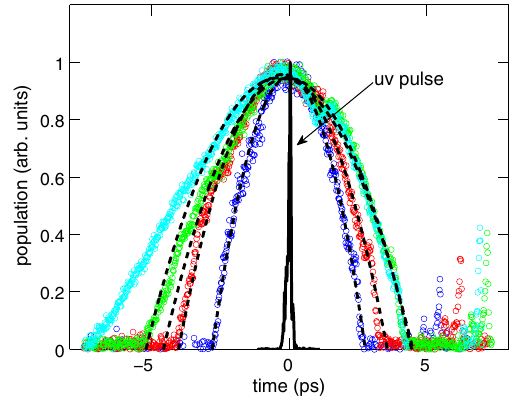
FIG. 12. Measured peak-normalized temporal profiles for Q ’ 130 , 280, 460, and 700 pC (respectively shown as blue, red, green, and cyan circles), compared with the measured uv laser temporal profile (black solid trace). The dashed lines represent the results of parabolic fits to the measured profiles. The head of the bunch corresponds to t > 0 .